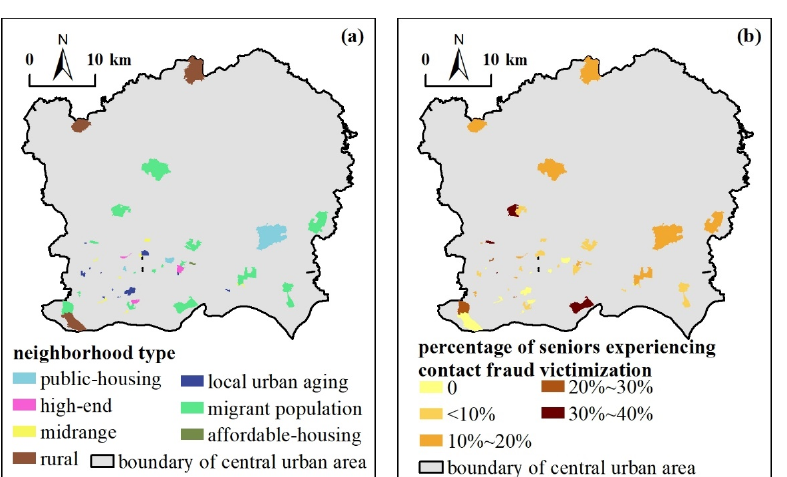
Figure 2. Typical neighborhoods surveyed by questionnaire. ( a ) shows the distribution of sample neighborhoods featured with different neighborhood types. ( b ) shows the distribution of sample neighborhoods featured with the percentage of seniors experiencing contact fraud victimization. Table 1. Distribution of the